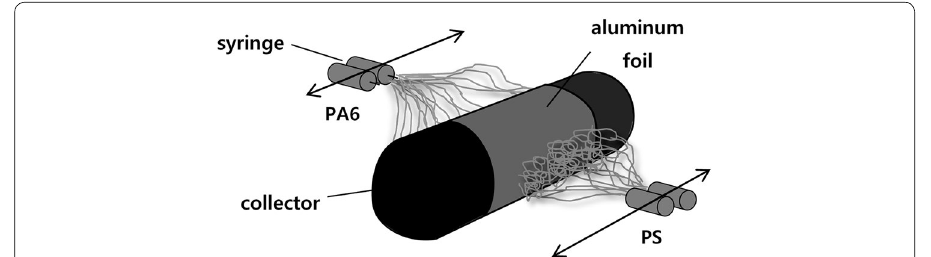
Fig. 1 Schematic on multi-jet electrospinning